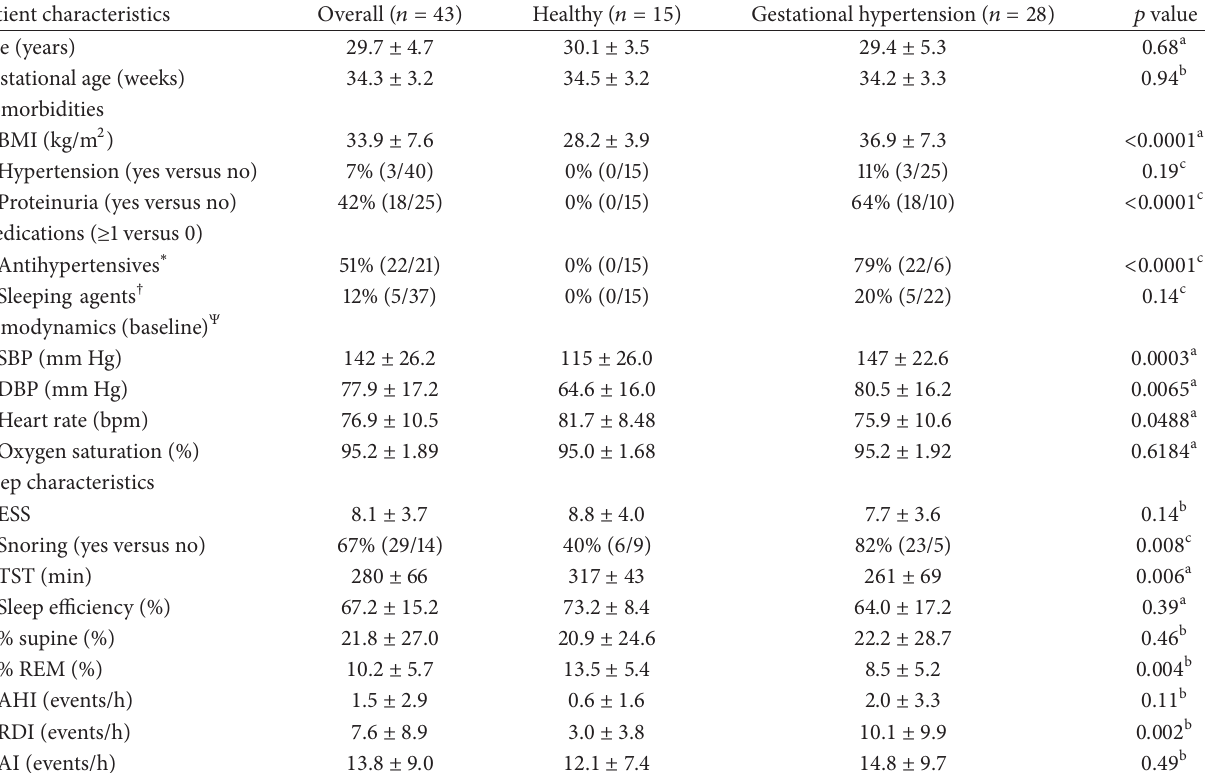
Table 1: Characteristics of patients in the study sample with Portapres monitoring. All values are mean ± standard deviation unless otherwise noted.